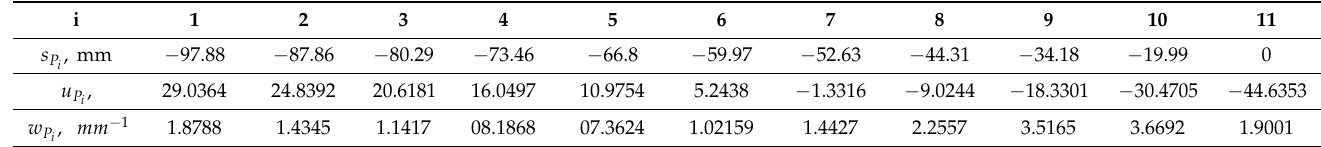
Table 4 shows the obtained values of the positions s P and analogues of the linear velocities u P and linear accelerations w P of the output slider P. Table 4. Positions and anologues of the linear velocities and accelerations of the output slider P .